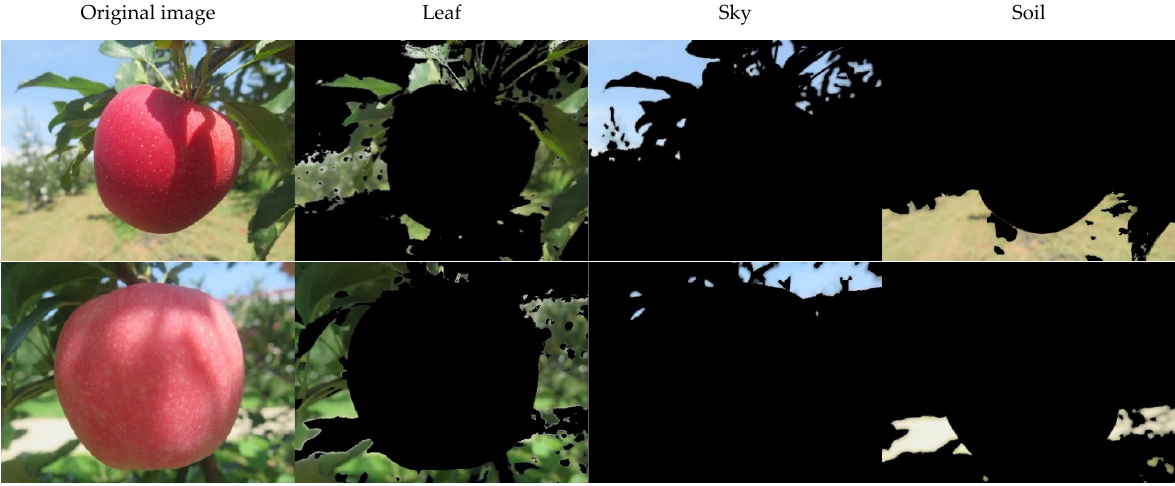
Figure 10. Feature maps of leaves, sky, and soil under specific